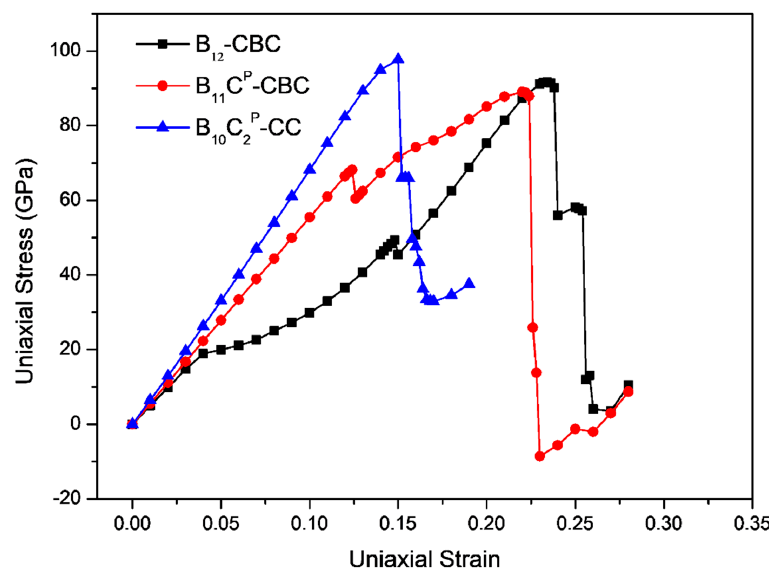
–CC configurations 2